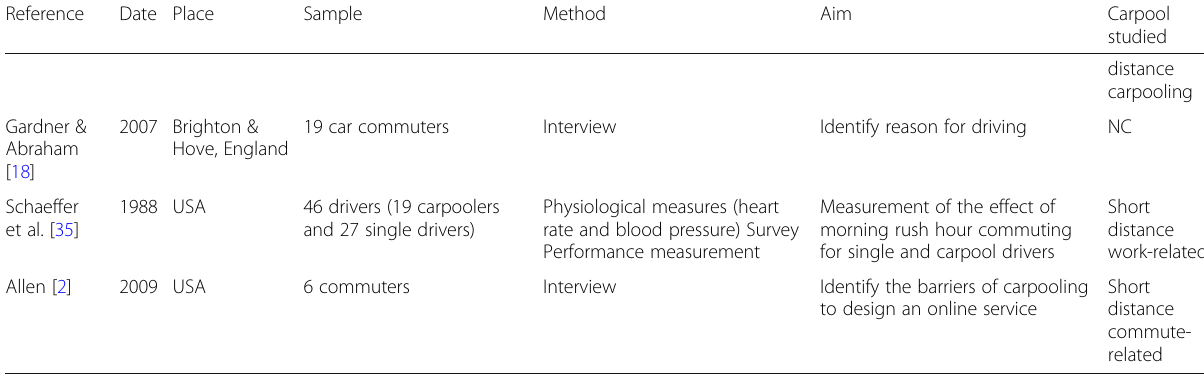
Table 1 Summary of the considered literature about carpooling (in the text below by order of appearance) (Continued)